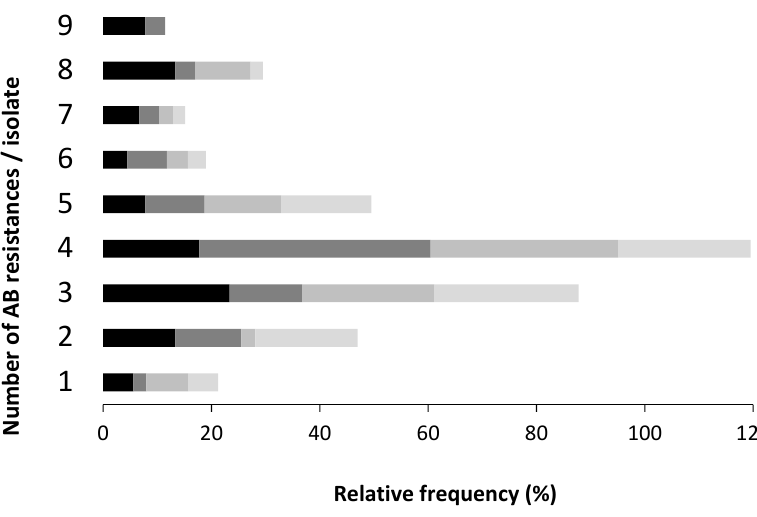
Figure 3. Relative frequency of the number of antibiotics to which each isolate resists. Enterprise